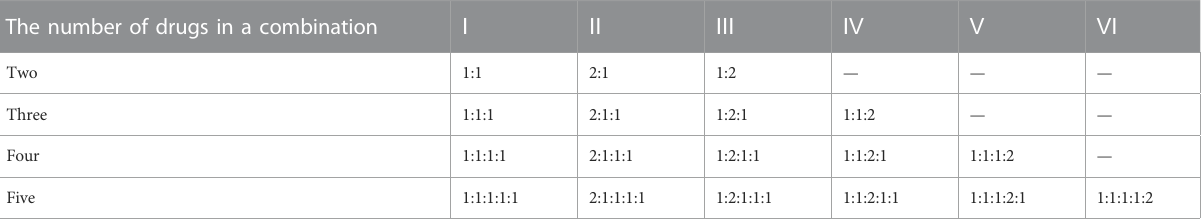
TABLE 1 The settings of concentration ratios for different drug combinations. The number of drugs in a combination